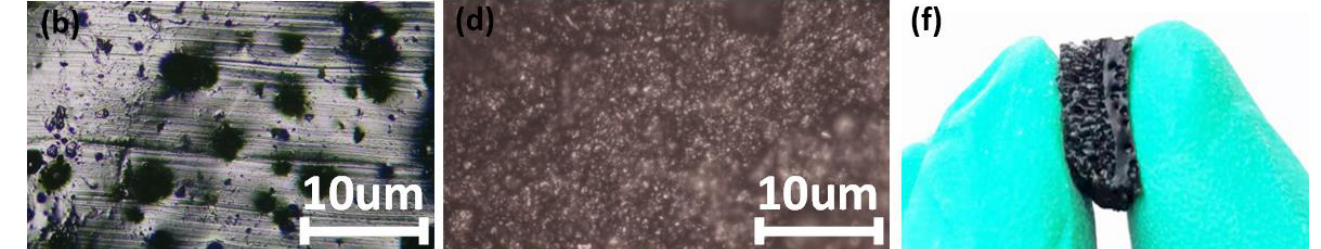
Figure 3. The optical microscope pictures of the fabricated dielectrics and copper electrodes: ( a ) the surface of pure PDMS. ( b ) The surface of porous PDMS doped 4 wt% NH 4 HCO 3 . ( c ) The surface of the copper electrode. ( d ) The surface of the copper electrode treated with MWCNTs. ( e ) The picture of fabricated dielectrics. ( f ) The cross-section view of the fabricated dielectric.